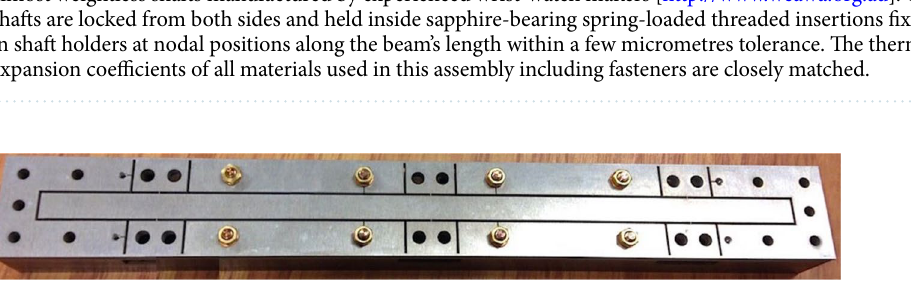
Figure 5. A free-hinged-hinged-hinged-free beam made by precision EDM process. The whole structure is wire cut with about 3–5 microns tolerance from a single piece of flat metal foil. In this case, the hinges represent micro-pivots of an optimum cross section connecting the middle flexible section (ribbon) to the rest of the frame. Material shown is a composite Tungsten/Copper